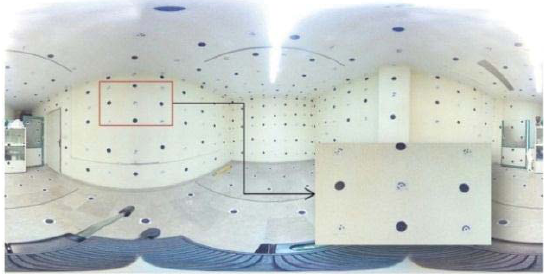
Figure 6. Illustration of targets in calibration